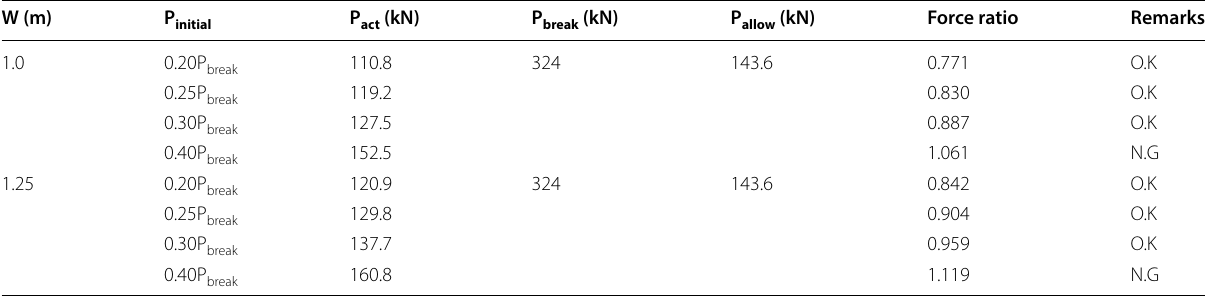
Table 9 Force ratio of the